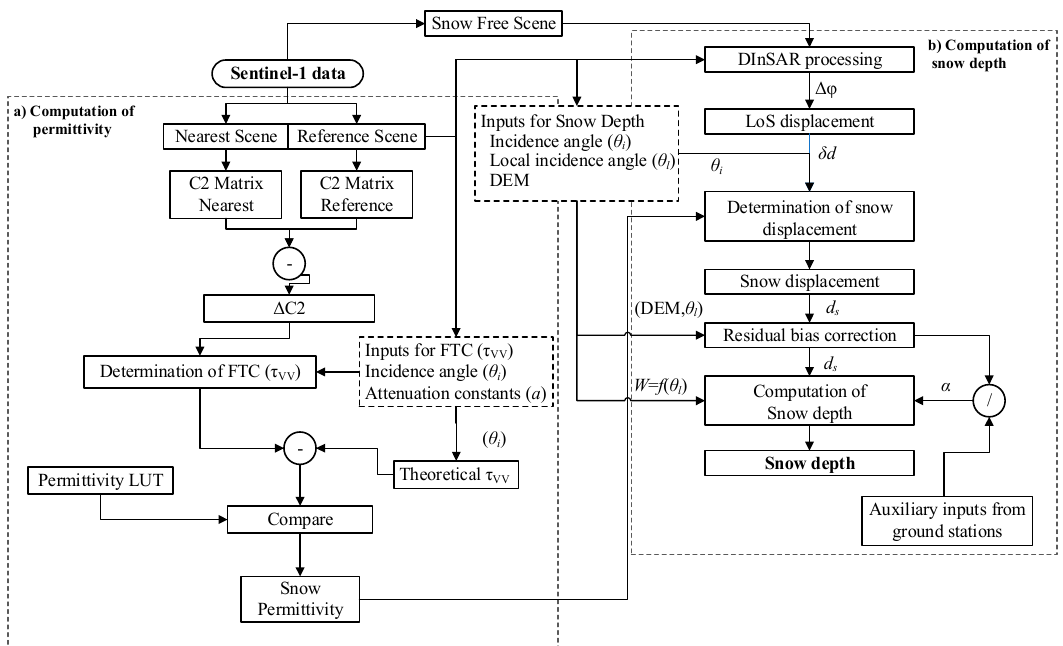
Figure 5. The detailed flowchart for the proposed method. Part ( a ) illustrates the computation of the snow permittivity, and part ( b ) shows the incorporation of the estimated snow permittivity in the modeling of snow depth.